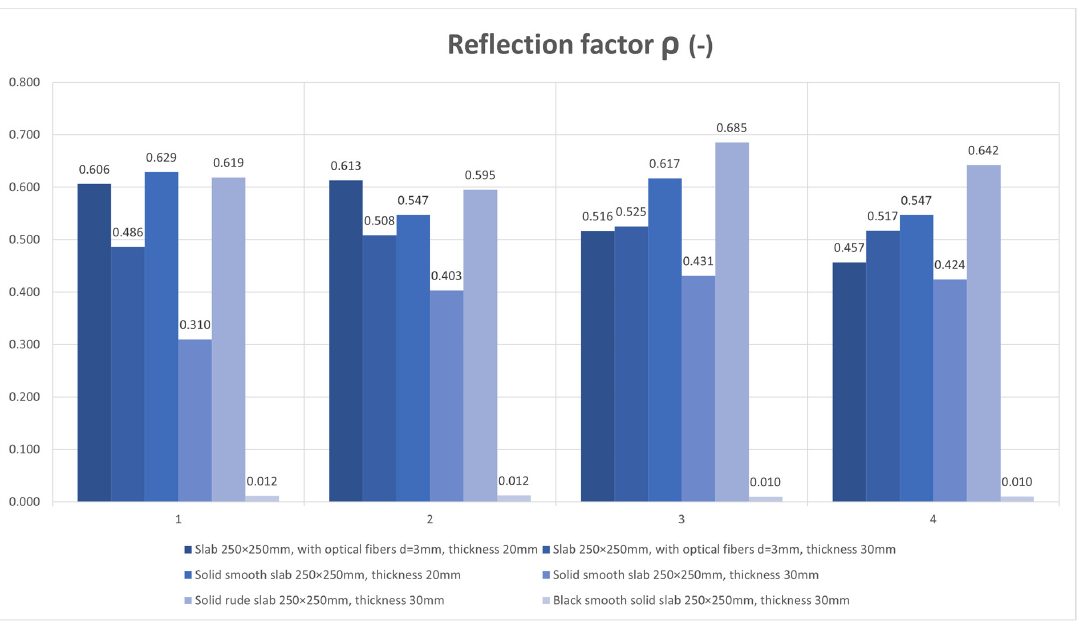
Figure 33. Illumination E (lx).